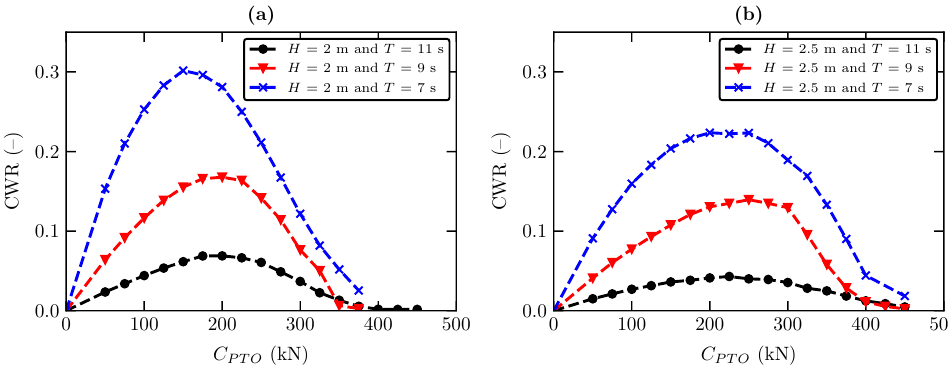
Figure 9. Influence of breakwater porosity and geometry and PTO damping on the CWR for T = 7, 9 and 11 s and ( a ) H = 2 m and ( b ) H = 2.5 m.